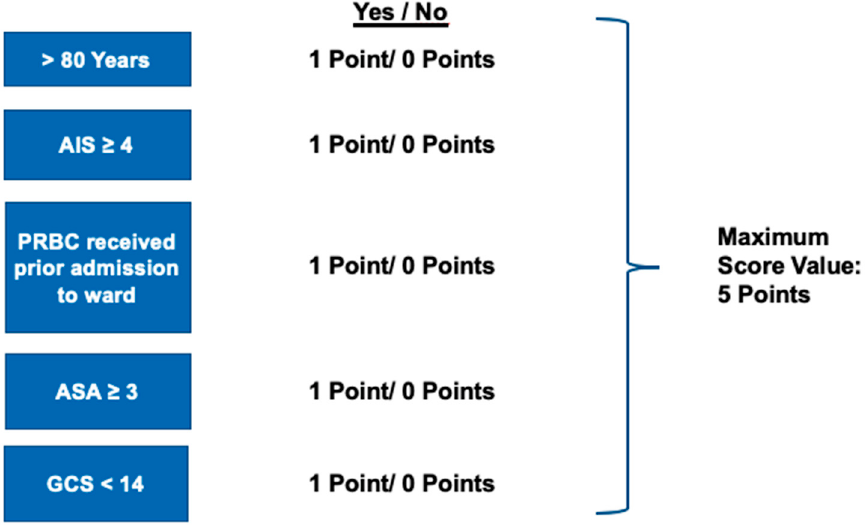
Figure 2. Relevant variables for the GERtality score. ASA, American Society of Anesthesiologists, GCS, Glasgow Coma Scale.